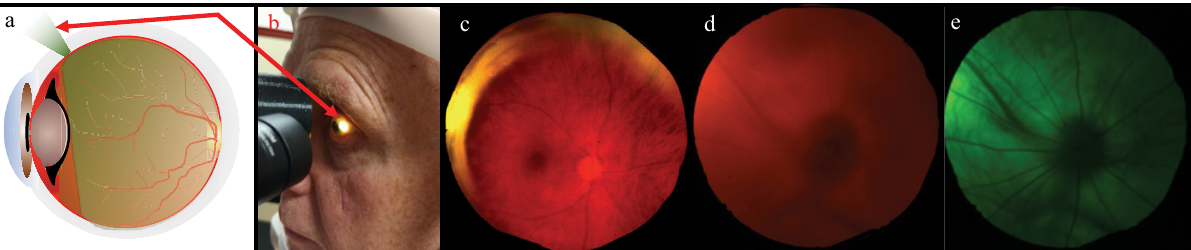
Figure 2: Handheld system utilising trans-slceral illumination. a) Trans-scleral illumination separates illumination and imaging paths b) scleral illumination pattern on a human using a white-light LED c) image human fundus d) red-